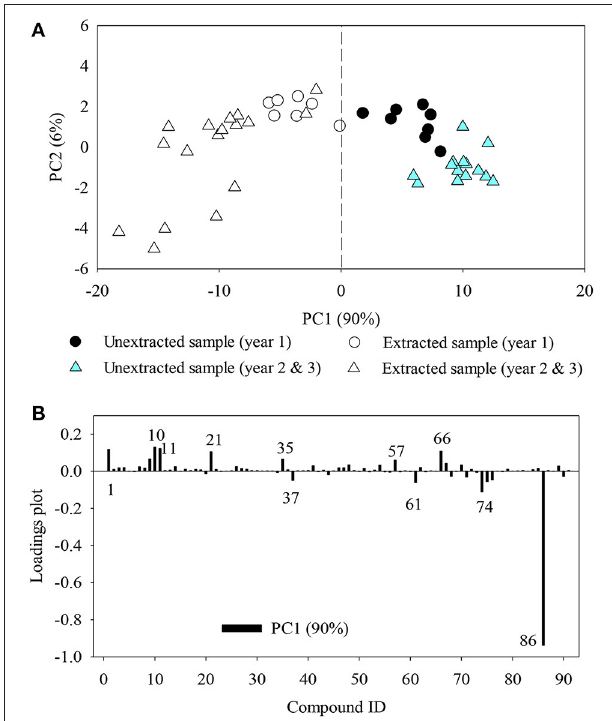
FIGURE 5 | PCA of the Py-GC/MS chromatographic peak area % of the unextracted and corresponding extractives-free switchgrass samples. (A) Scores and (B) loadings plots of the unextracted and extracted switchgrass